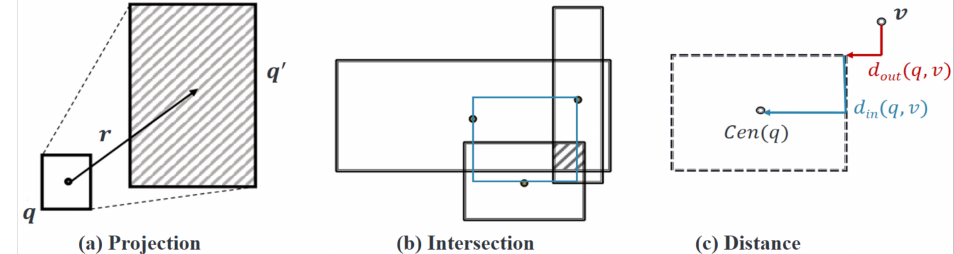
Figure 5. The geometric intuition of the projection and intersection operations in